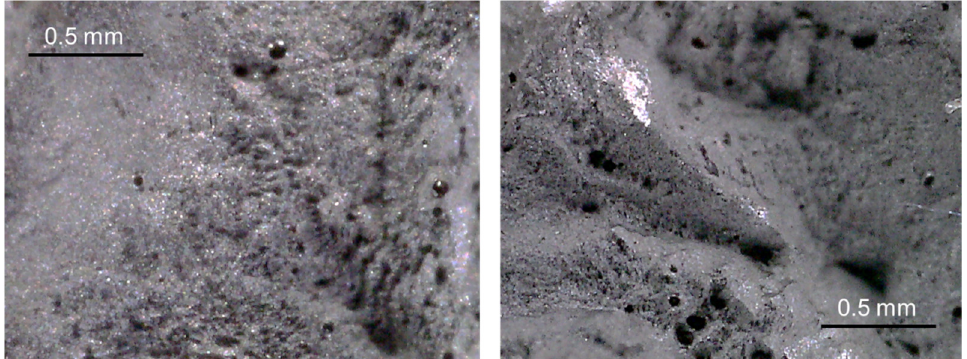
Figure 11. Frontal view of the fracture surface: ( left ) DA specimen tested in quasi-static condition at room temperature; ( right ) DA specimen tested in high strain rate condition at room temperature.